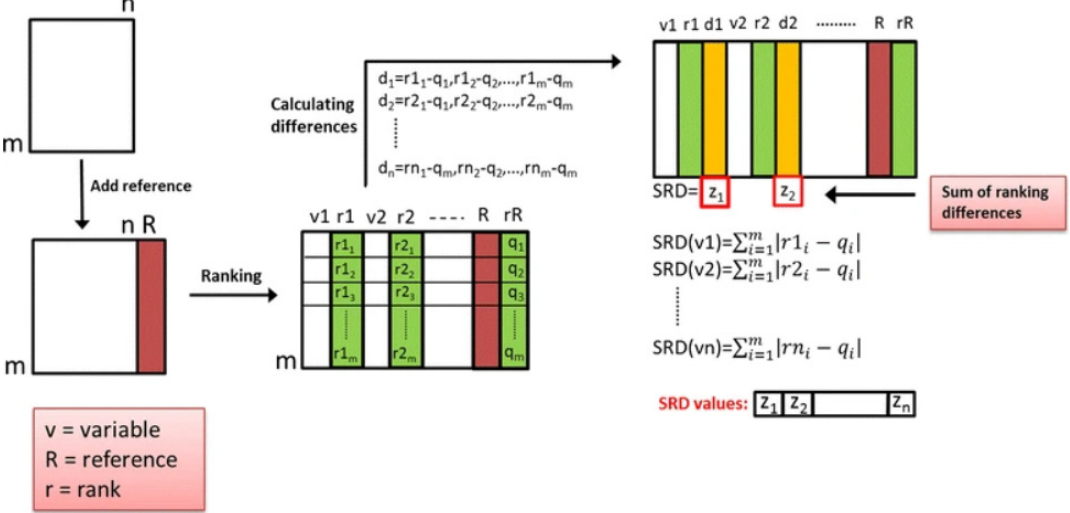
Figure 2. Scheme to calculate sum of ranking differences. The input matrix contains the methods to be compared (n = 8) in the columns and the measured variables (m = 99) in the rows. A reference column (golden standard, here: average of the measured variables) is added in the data fusion step (red). Then, all columns are doubled (green) and the molecules in each column are ranked by increasing magnitude (columns r1, r2, … rn). The differences (yellow columns) are calculated for each similarity measure and each molecule (i.e., each cell) between its rank (r1 1 , r1 2 to rn m ) and the rank assigned by the known reference method (rR = q 1 , q 2 , … q m ). In the last step, the absolute values of the differences are summed up for each measure to give the final sum of ranking differences (SRD) values, which are to be compared. Smaller SRD mean proximity to the reference—the smaller the better. Adapted from [107].